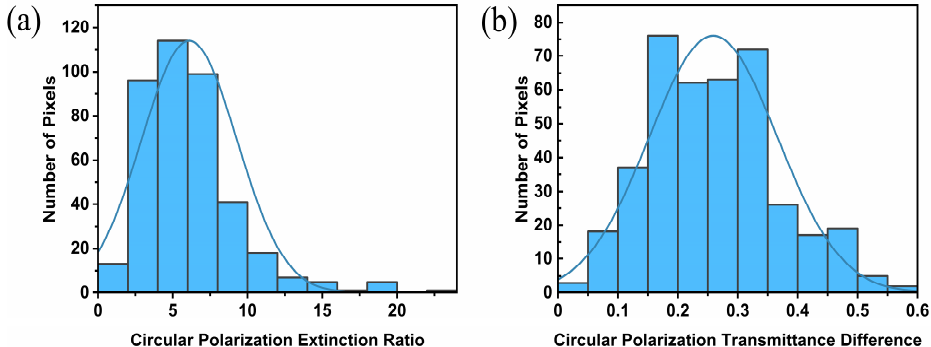
Figure 10. Histograms showing the distribution of ( a ) the circular polarization extinction ratio (CPER) and ( b ) the circular polarization transmittance difference (CPTD) across 400 regions.